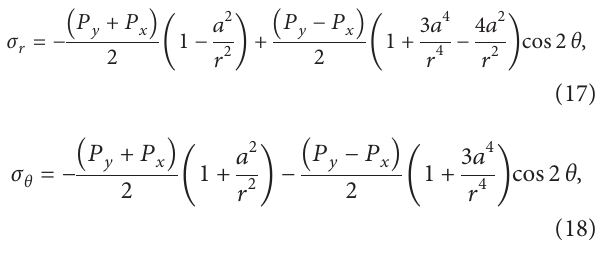
at gauge points. (b) Distributions of σ θ